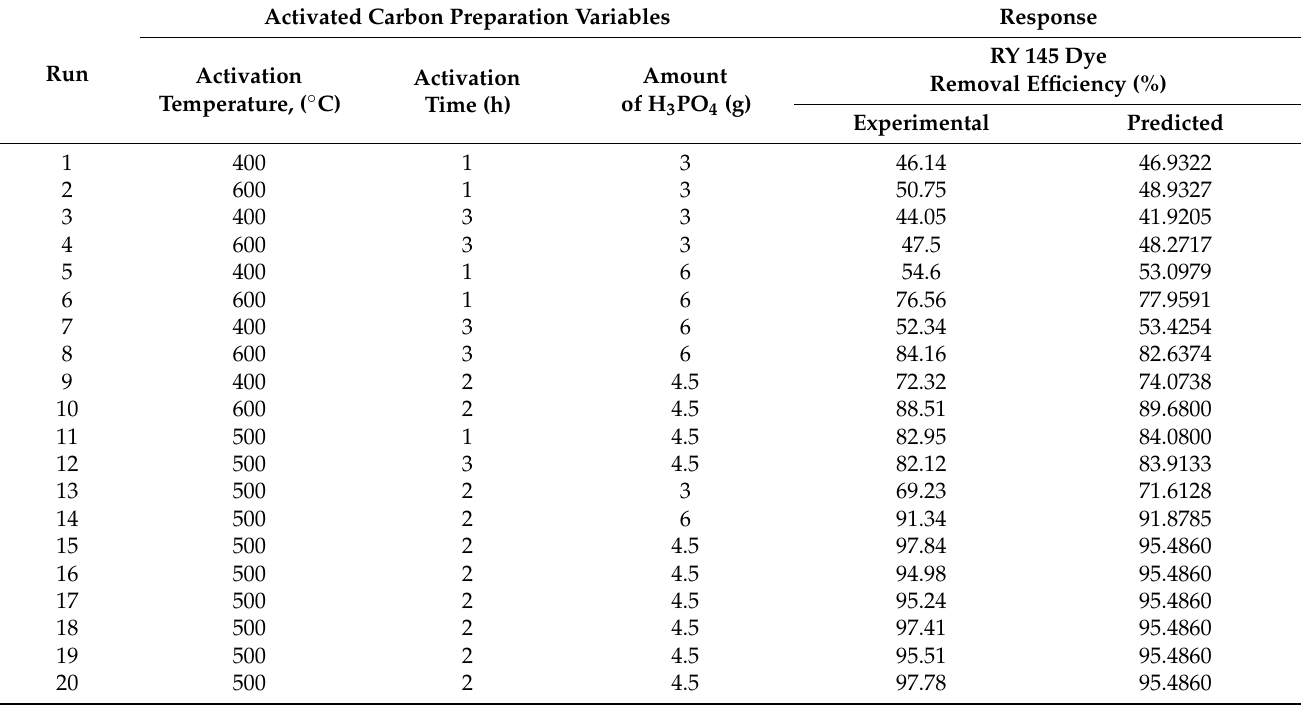
Table 4. The CCD design matrix and their corresponding response using